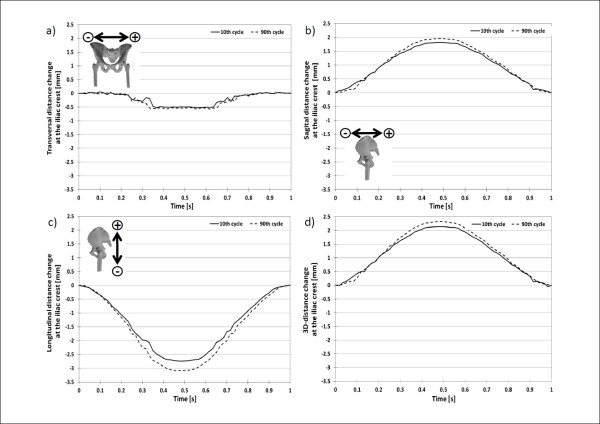
3D-deformation at the iliac crest. 3D-deformation between the two markers at the iliac crest at the 10th and 90th loading cycle with a sinusoidal load between 100N and 900N.